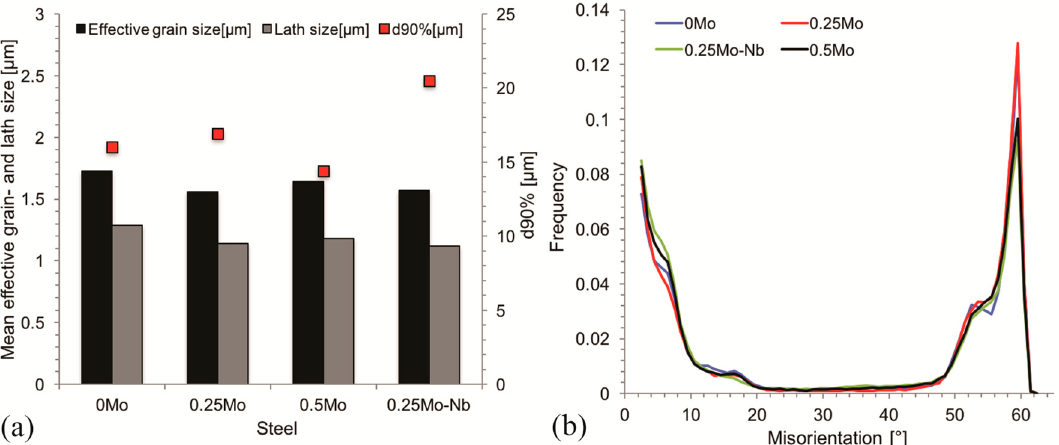
Figure 5. Results of the electron backscatter diffraction (EBSD) analysis in the as-quenched condition (FRT 900 °C). ( a ) Mean effective equivalent circle diameter (ECD) grain and lath sizes, and the ECD size of the coarsest grains ( d 90%), ( b ) grain boundary misorientation distributions (>2.5°).